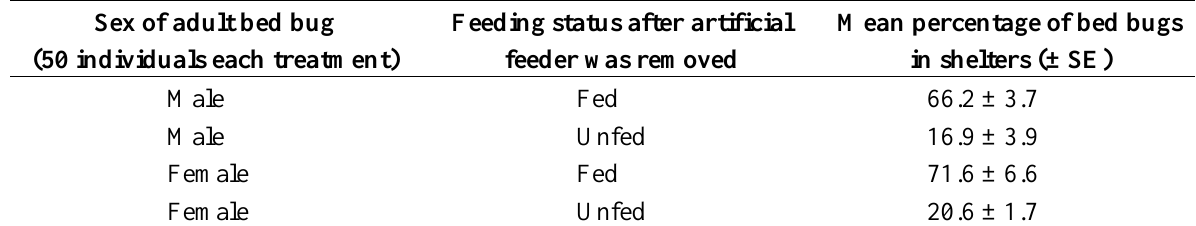
Table 1 . Mean percentage of male and female bed bugs ( n = 5) aggregating (every 30 min from 21:30–06:00 throughout the test period) in shelters after being stimulated to feed.